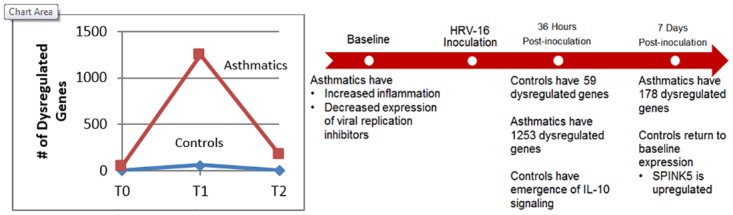
Summary of gene dysregulation in asthmatics versus controls from T0 to T2 (left) and summary of differences in innate immunity, including the epithelial barrier (right).These differences may contribute to increased magnitude and persistence of gene dysregulation in asthmatics in response to HRV infection.